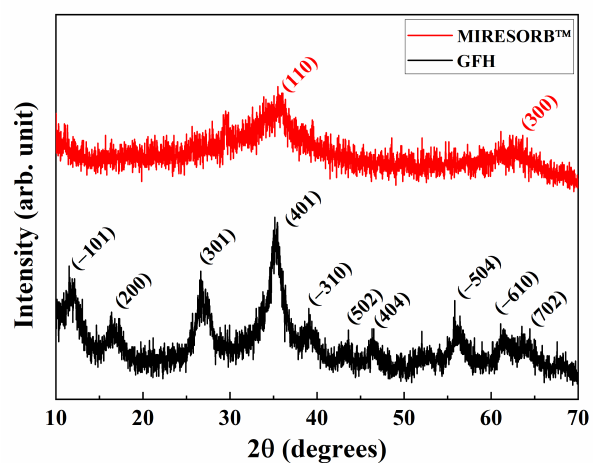
Figure 1. Powder X-ray diffractogram of granular ferric hydroxide (GFH) ( black line ) and MIRESORB TM ( red line ).